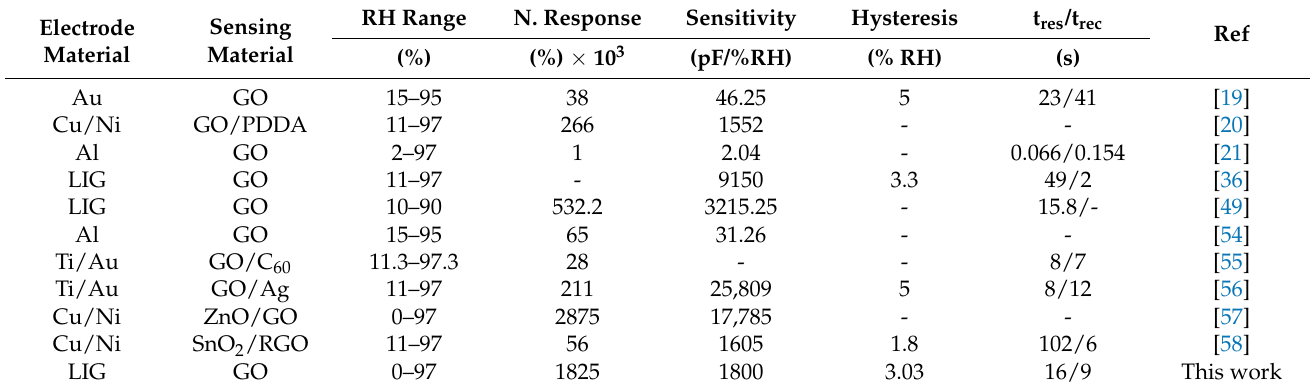
Table 1. Performance characteristics of the LIG/GO sensor with 50 nm of GO compared with previous